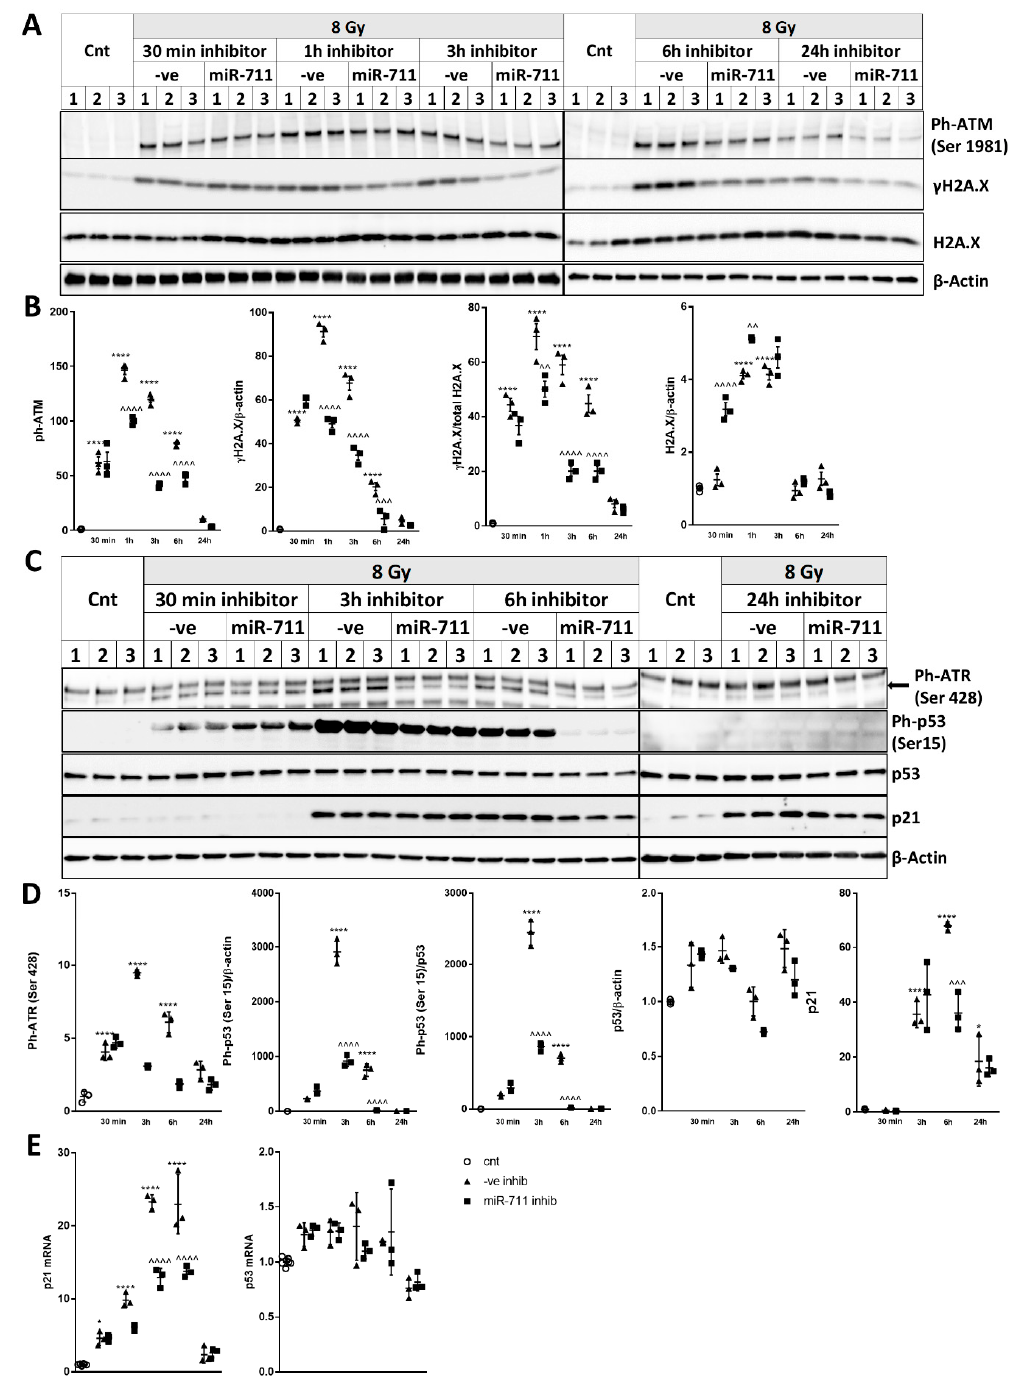
Figure 7. miR-711 inhibition attenuates IR-induced DNA damage markers, p53 activation, and neuronal apoptosis and senescence markers. Western blot for Ph-ATM(Ser1981), γ -H2A.X and H2A.X ( A ). ( B ) Ph-ATM(Ser1981) (F(10,22) = 173, p < 0.0001 at 30 min, 1 h, 3 h and 6 h after IR with miR-ve inhibitor, compared to control for miR-711 inhibitor, compared to miR-ve inhibitor, p < 0.0001at 1 h and 3 h, p = 0.0001 at 6 h), γ H2A.X normalized to β -actin (F(10,22) = 281.7, p < 0.0001 for all time points except 24 h after IR with miR-ve inhibitor, compared to non-irradiated control; for miR-711 inhibitor, compared to miR-ve inhibitor, p < 0.0001 for 1 h and 3 h, p = 0.0005 for 6 h), γ H2A.X normalized to H2A.X (F(10,22) = 73.18, p < 0.0001 for all time points except 24 h after IR with miR-ve inhibitor, compared to control for miR-711 inhibitor, compared to miR-ve inhibitor, p = 0.0017 at 1 h, p < 0.0001